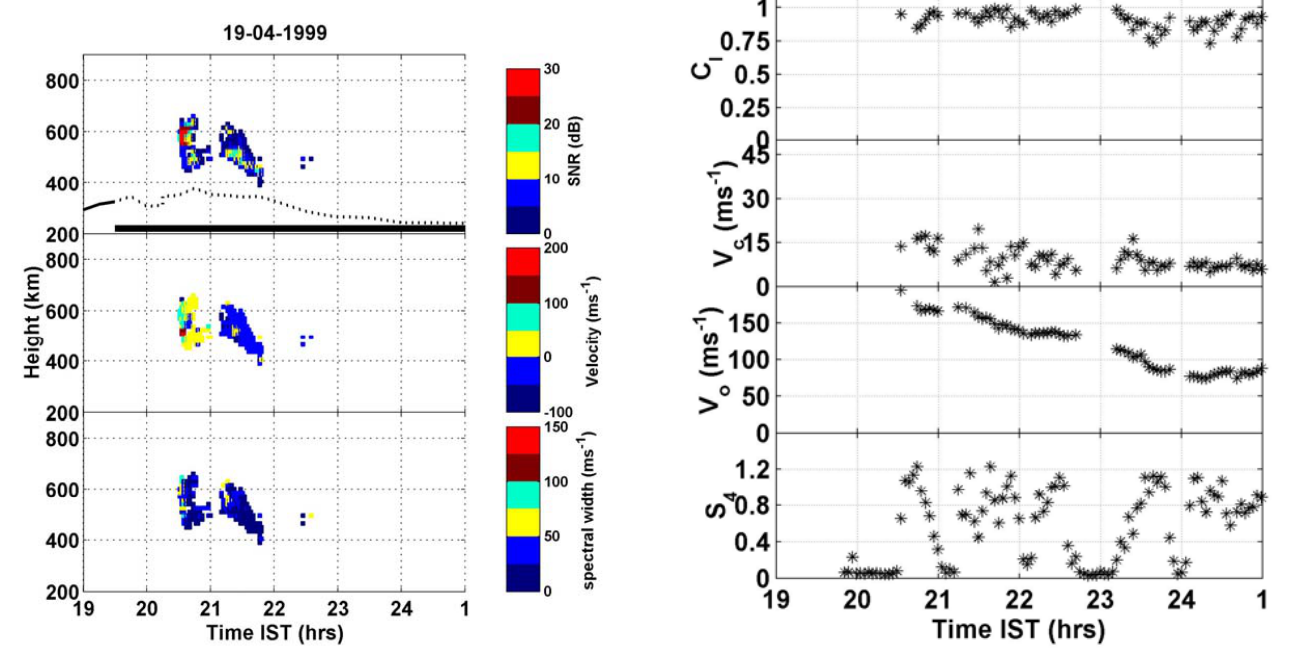
Fig. 3. (a) Same as Fig. 1a but for 19 April 1999. (b) Same as Fig. 1b but for 19 April